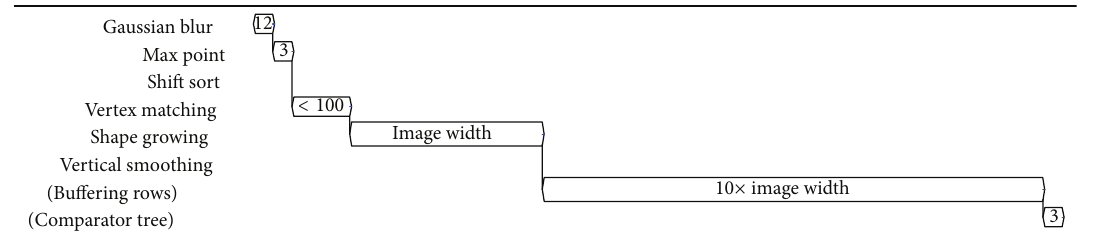
Figure 7: Average latency of pixel disparity results in clock